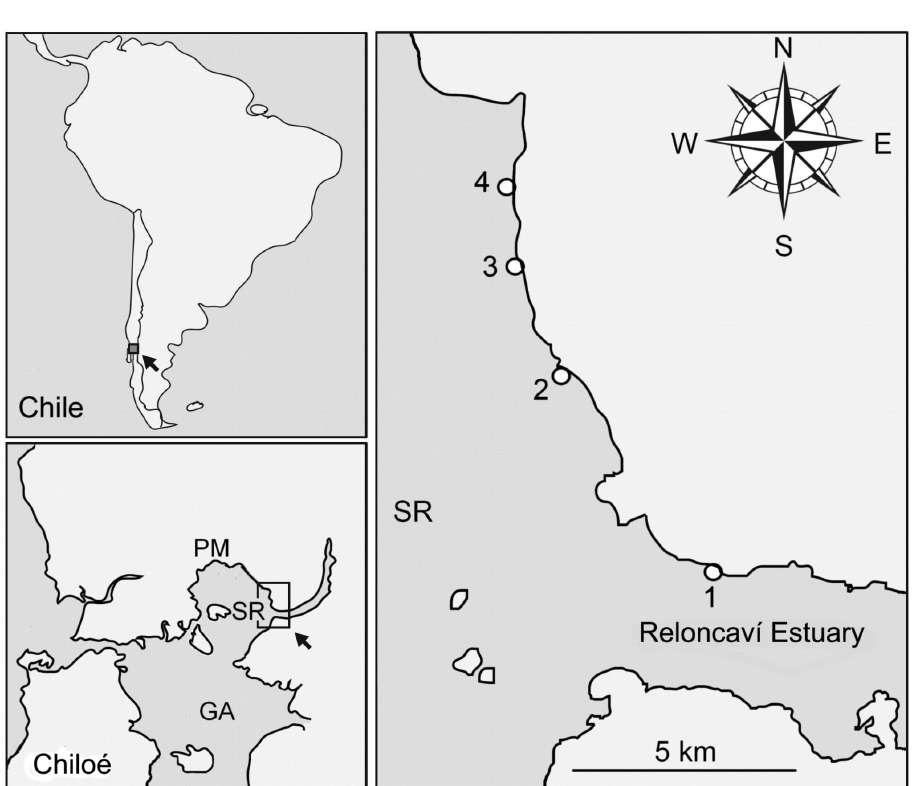
Figure 2. The study was carried out in Southern Chile (upper left) in the Reloncaví Sound (lower left) in its eastern part (right). 1 Reloncaví Estuary 2 Caleta Yerbas Buenas 3 Caleta Gutiérrez 4 Caleta Chaicas; PM = Puerto Montt; GA = Golfo de Ancud; SR = Reloncaví